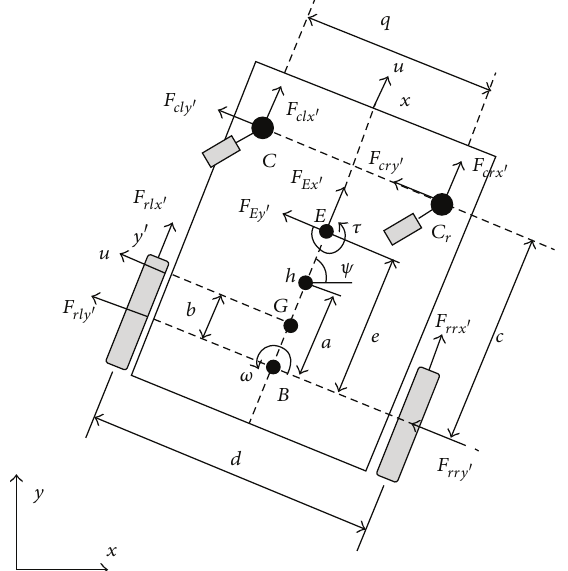
Figure 5: Parameters of the dynamic model of the robotic wheelchair. The relevant parameters are 𝑢 linear velocity, 𝜔 angular velocity, 𝐺 center of mass, 𝑐 middle point between front wheels, 𝐸 mass center of the user location, ℎ : (𝑥, 𝑦) point of interest, 𝜓 robot orientation, and 𝑎 distance between ℎ and the central point of the virtual axis of the traction